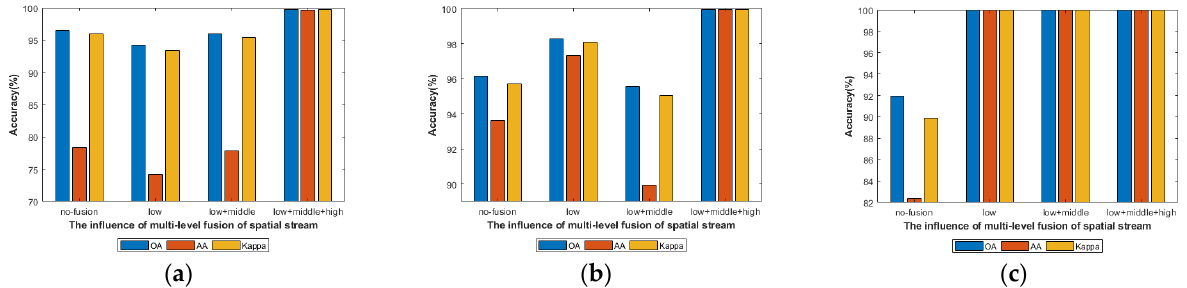
Figure 19. The influence of multi-level spatial feature fusion structure. ( a – c ) represent the influence of multi-level spatial feature fusion structure on IN, KSC and SA, respectively.